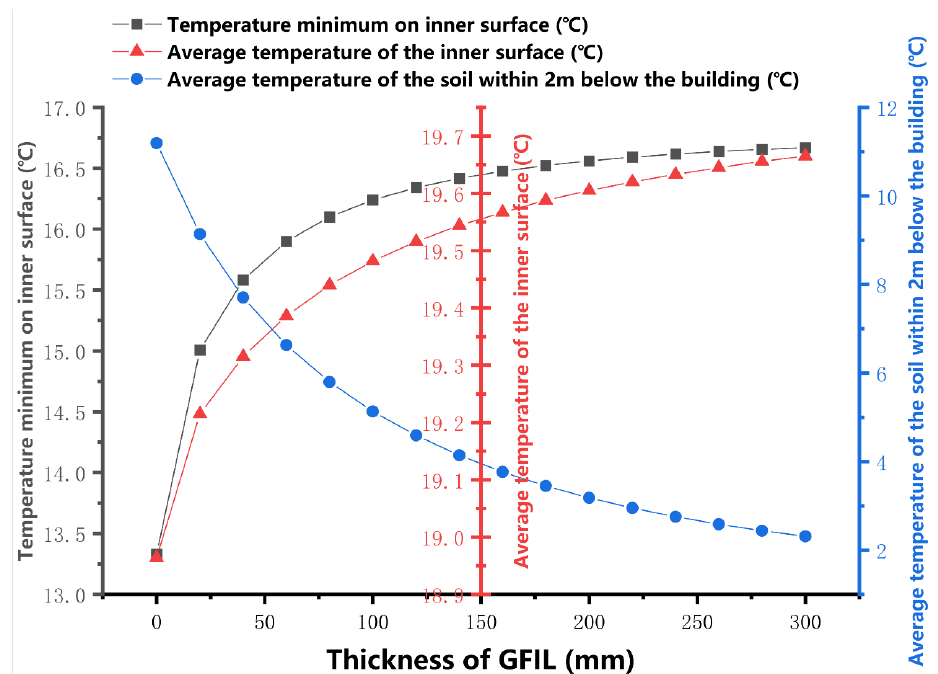
Figure 8. Thickness of GFIL versus each temperature. Table 5. Simulation results for Group A and B working conditions.